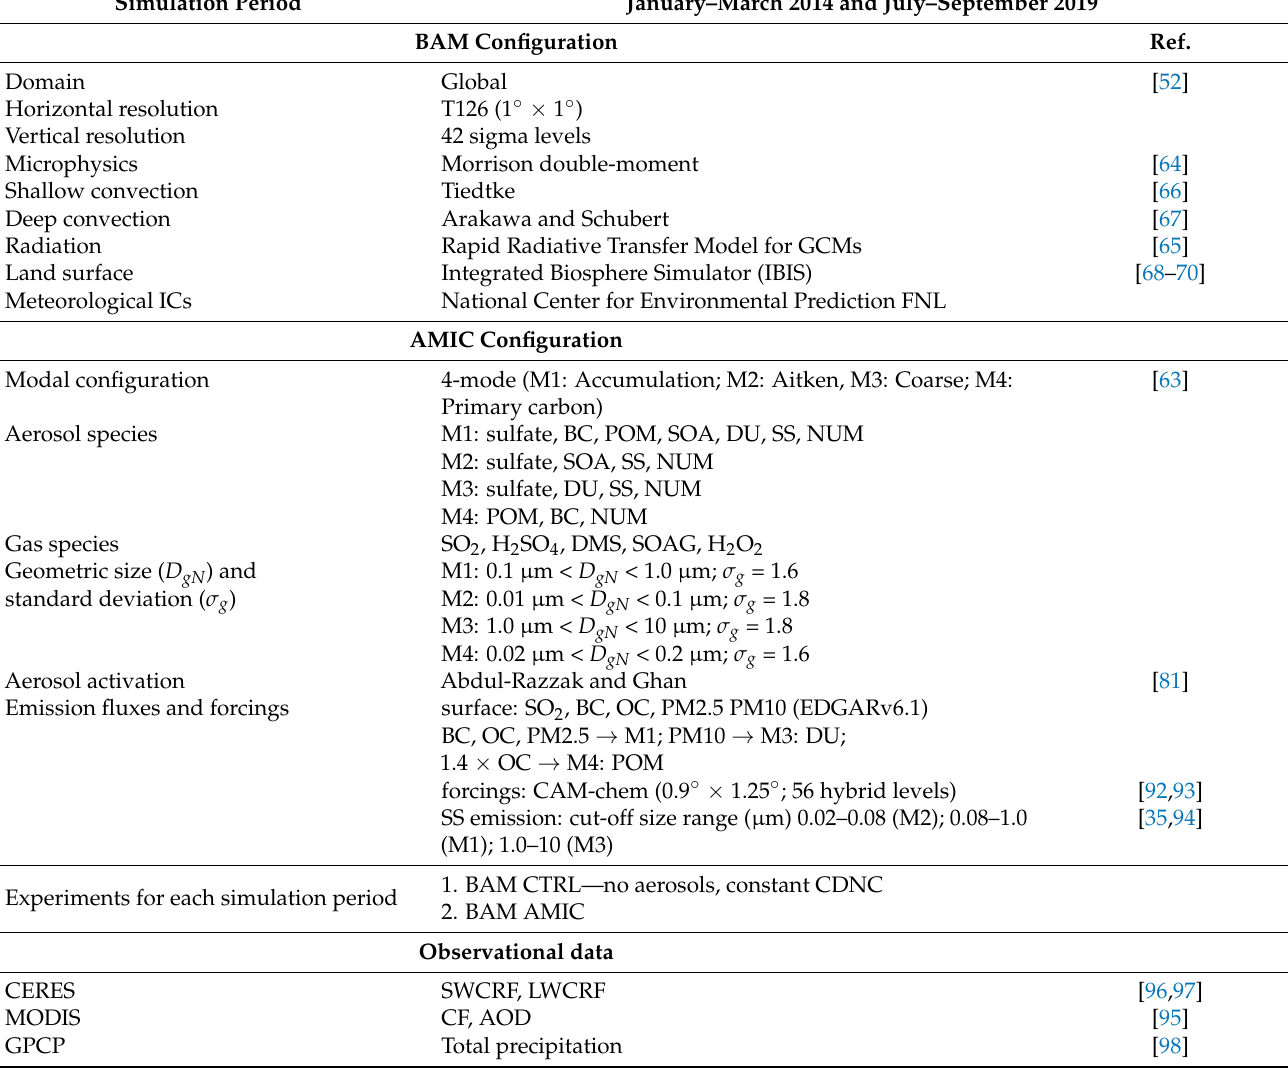
Table 1. Model configuration and